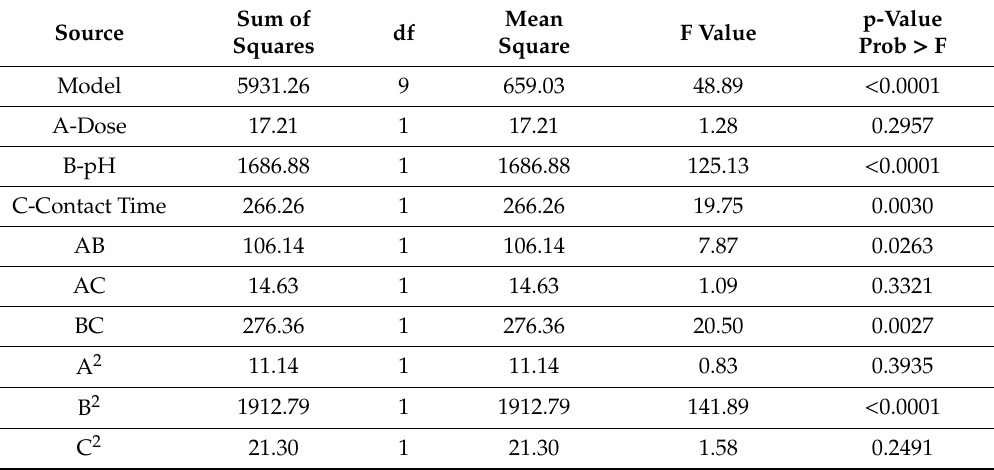
Table 7. ANOVA of optimization Al 3 + removal (%) on bio-powder activated carbon